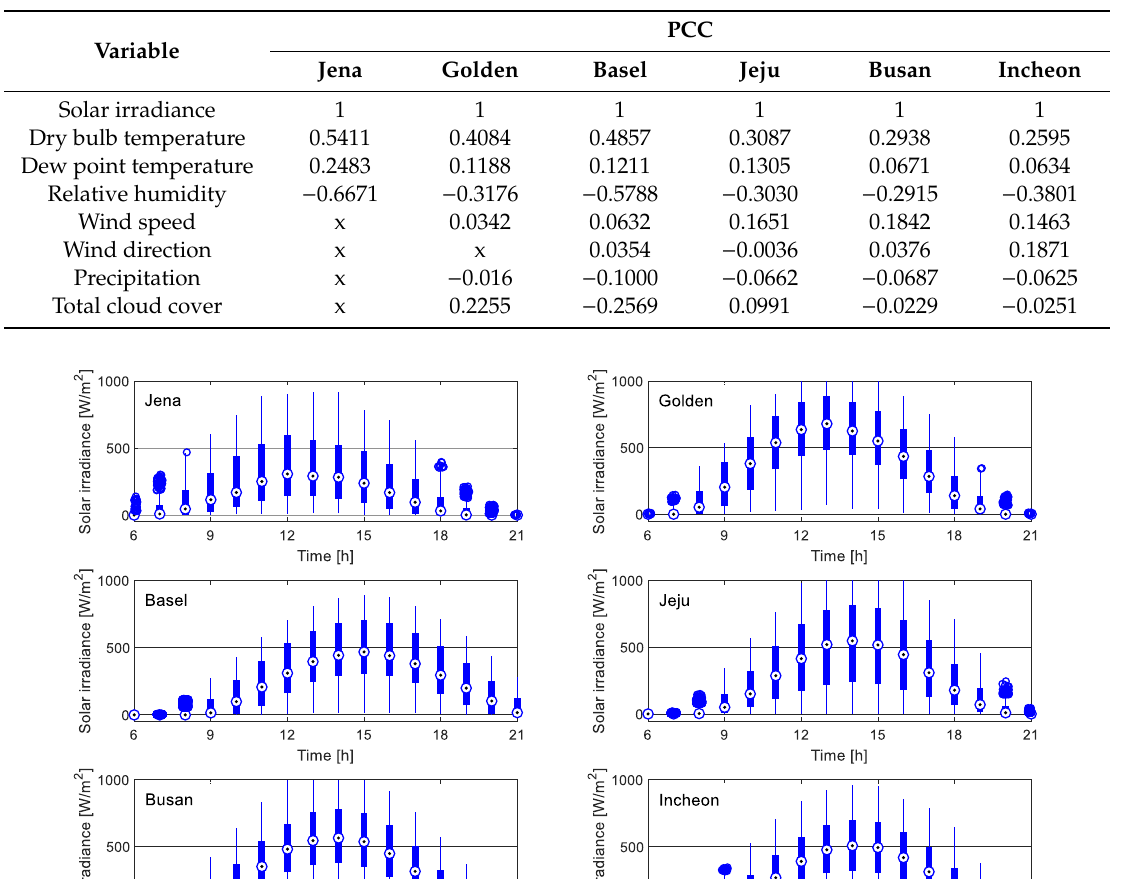
Table 3. Meteorological parameters and their Pearson Correlation Coefficient (PCC) with solar irradiance.